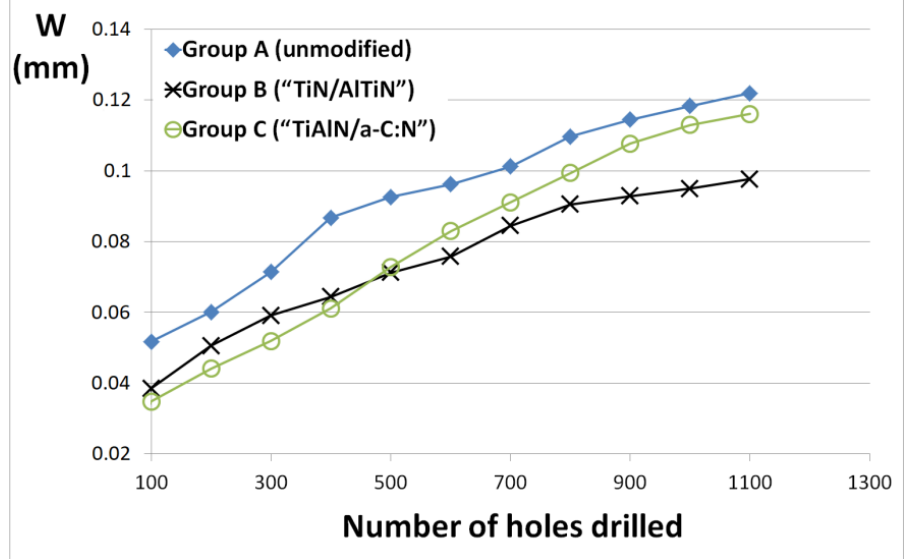
Figure 15. The averaged blade wear curves for all groups (Groups A, B, and C).